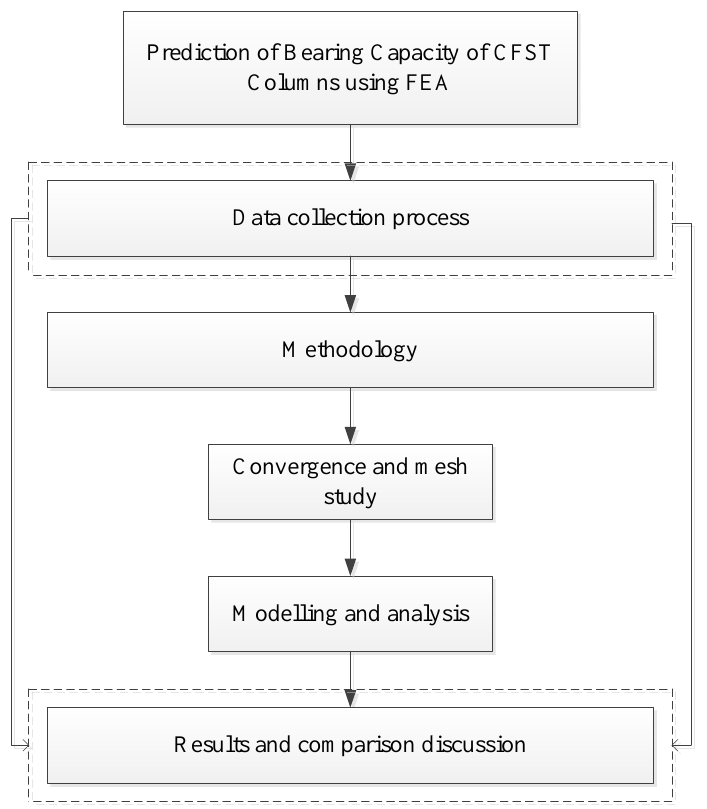
Figure 1. Diagram of finite element analysis (FEA) of the concrete-filled steel tube (CFST) columns.